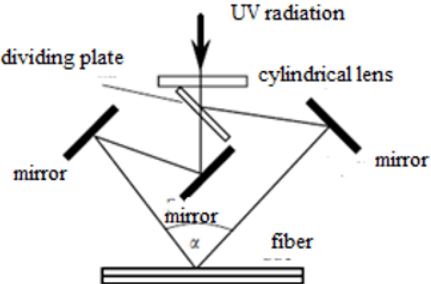
Fig. 2. Scheme of FBG recording in interferometer with beam amplitude separation of UV radiation.